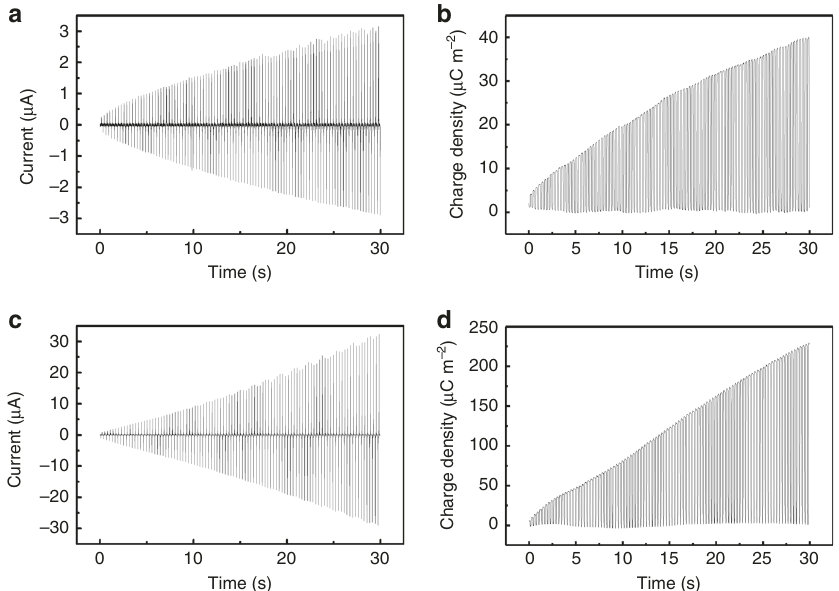
Fig. 6 Performance enhancement of charge accumulation speed. a , b Show the output current and effective charge density of part I at the beginning of the charge accumulation process. c , d show the output current and effective charge density of the self-improving triboelectric nanogenerator (SI-TENG) at the beginning of the charge accumulation